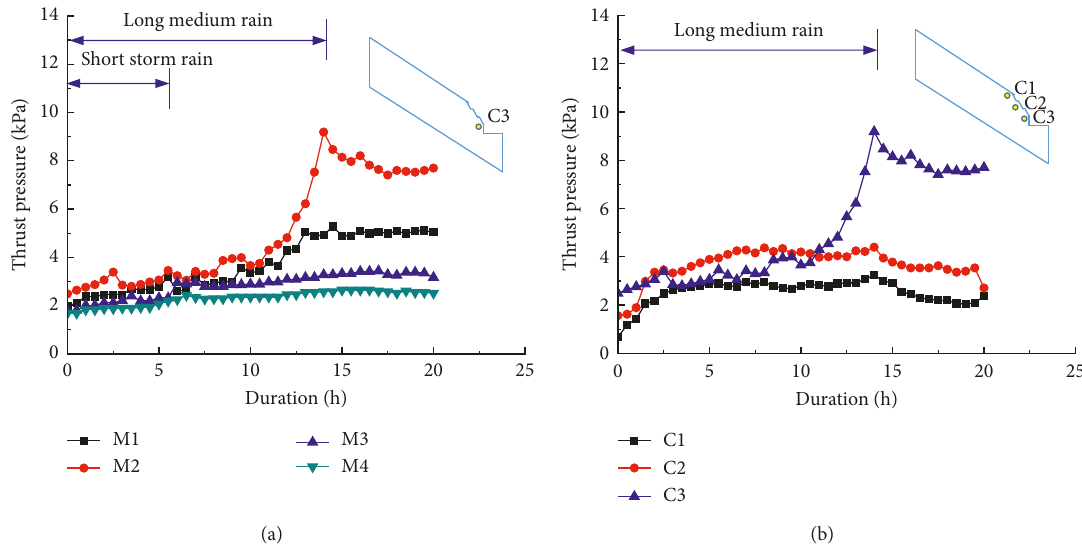
Figure 8: Thrust pressure on the reinforced structures: (a) thrust at point C3 for different slope models; (b) thrust at different locations for slope